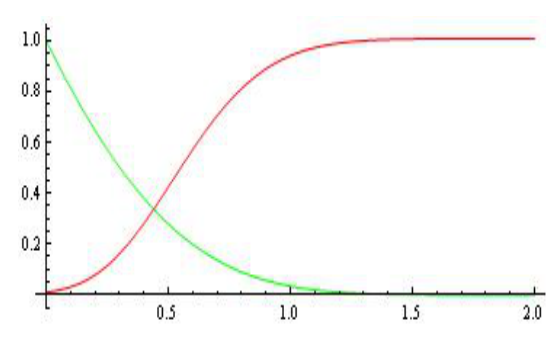
Fig. 12. The ”growth” function y ( t ) –(red) and s ( t ) –(green) for k = 12 . 6; q = 0 . 14; y 0 = 0 . 01 .